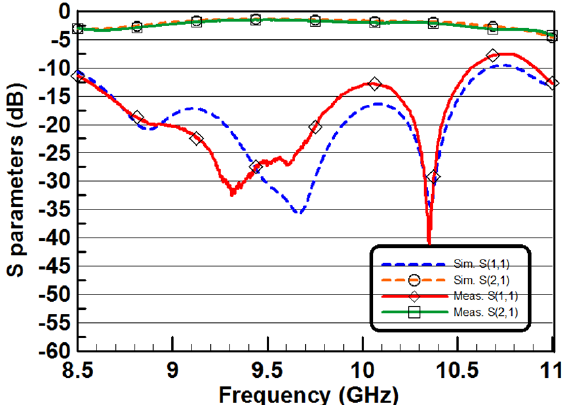
Figure 6: Simulated and measured results of the back-to- back 4-to-1 power